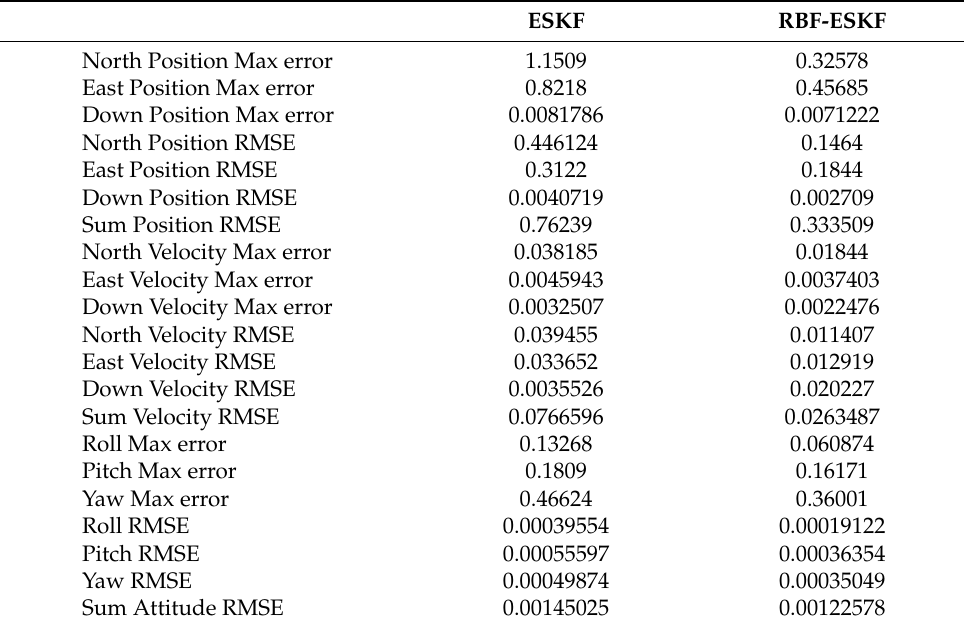
Table 3. ESKF and RBF-ESKF results with all sensors working in normal condition by running 100 Monte Carlo simulations.